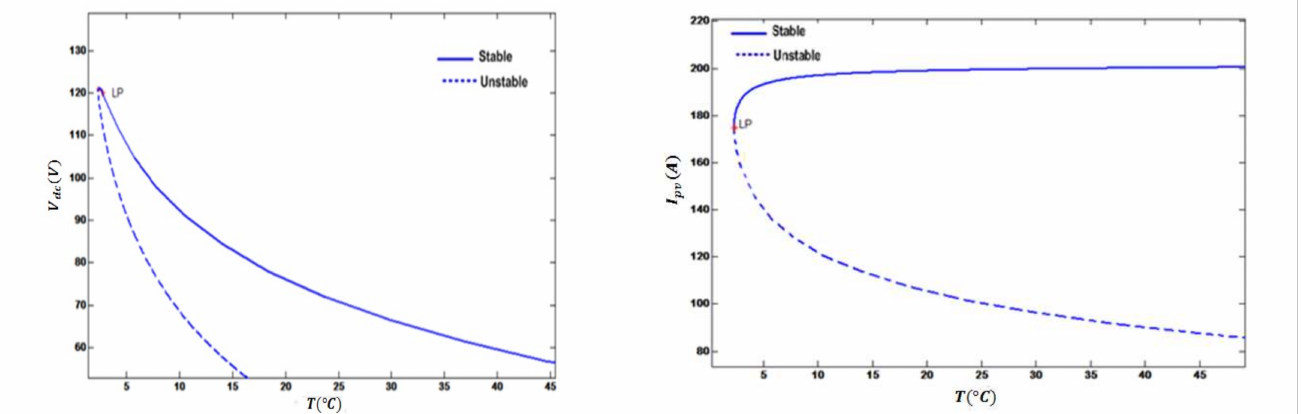
Figure 4. Saddle-Node bifurcation due to temperature changes. LP : x = ( − 99.4,0.23,204.9,120.6 ) , T = 2.32, λ 1,2 = − 4260.96 ± j 615.99, λ 3 = − 331.15, λ 4 =